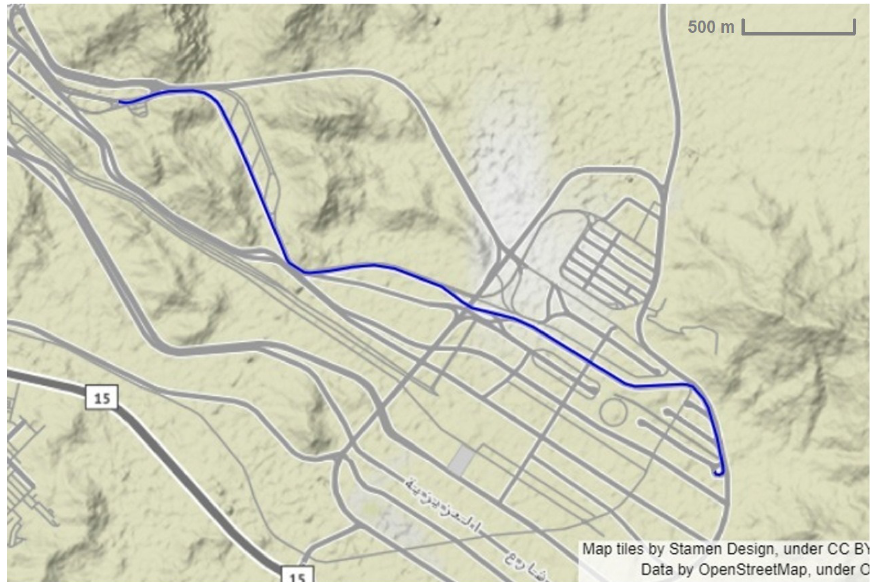
Figure 9. After Interpolation shuttle bus service path (blue color) between Arafat and